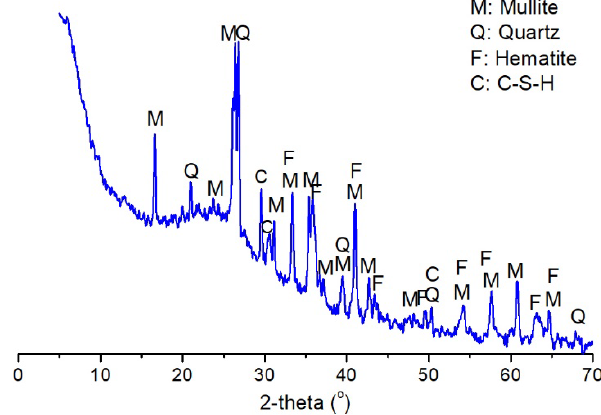
Figure 2. X-ray diffraction (XRD) patterns of LFA.